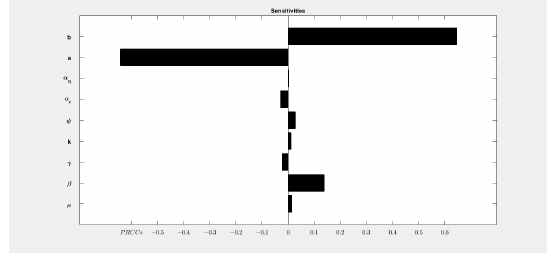
Figure 4. Sensitivity of treatment reproduction number to parameters it depends on.